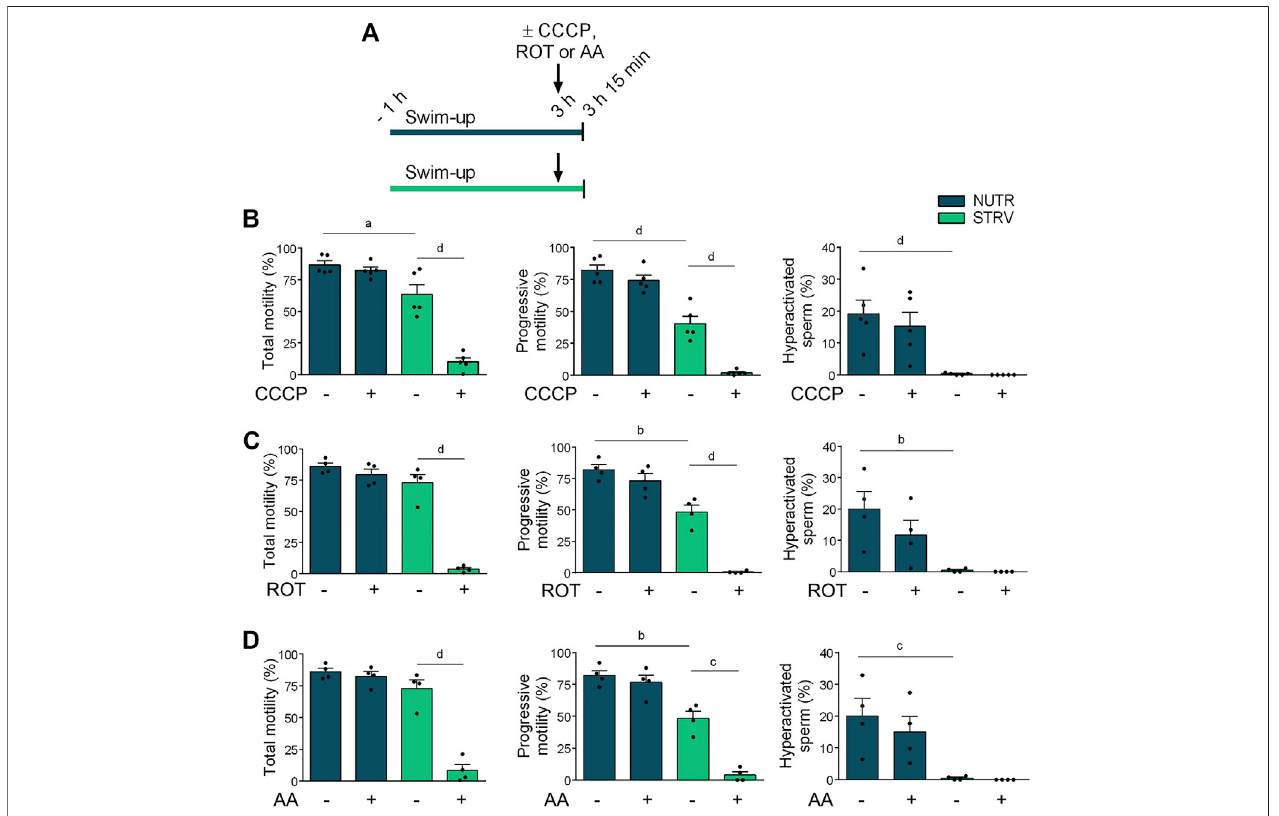
FIGURE 3 | Effect of incubation with OXPHOS inhibitors on human sperm motility. (A) Experimental design. Motile human sperm were selected and incubated for 3 h in NUTR or STRV medium. The OXPHOS inhibitors (10 µM CCCP, 1 µM ROT or 0.3 µM AA) were added (indicated with arrows) and after 15 min, motility was recorded by CASA. (B) Motility parameters in sperm exposed to CCCP. (C) Motility parameters in sperm exposed to ROT. (D) Motility parameters in sperm exposed to AA. Results are expressed as mean ± SEM, n ≥ 4 experiments. a p < 0.05, b p < 0.01, c p < 0.001, d p < 0.0001. One-way ANOVA, and Tukey ’ s multiple comparison